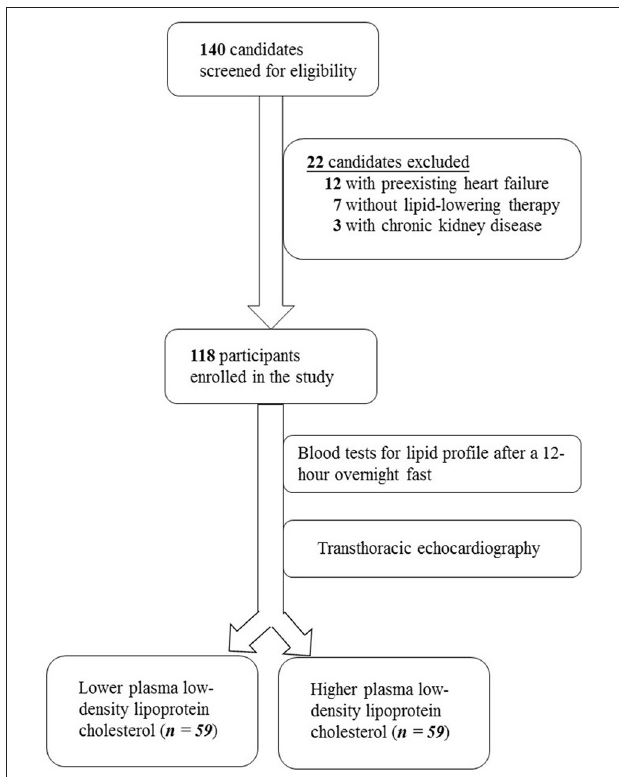
FIGURE 1 | Enrollment protocol of the